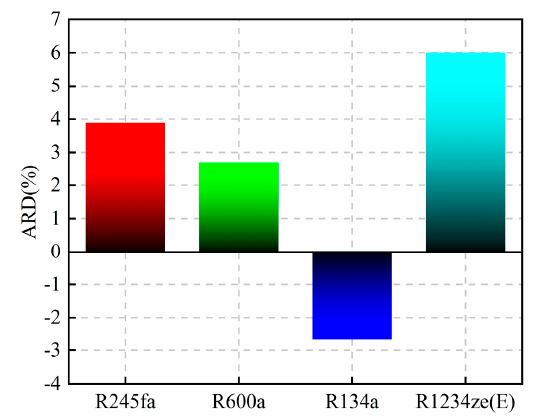
Figure 10. ARD of thermal efficiency.